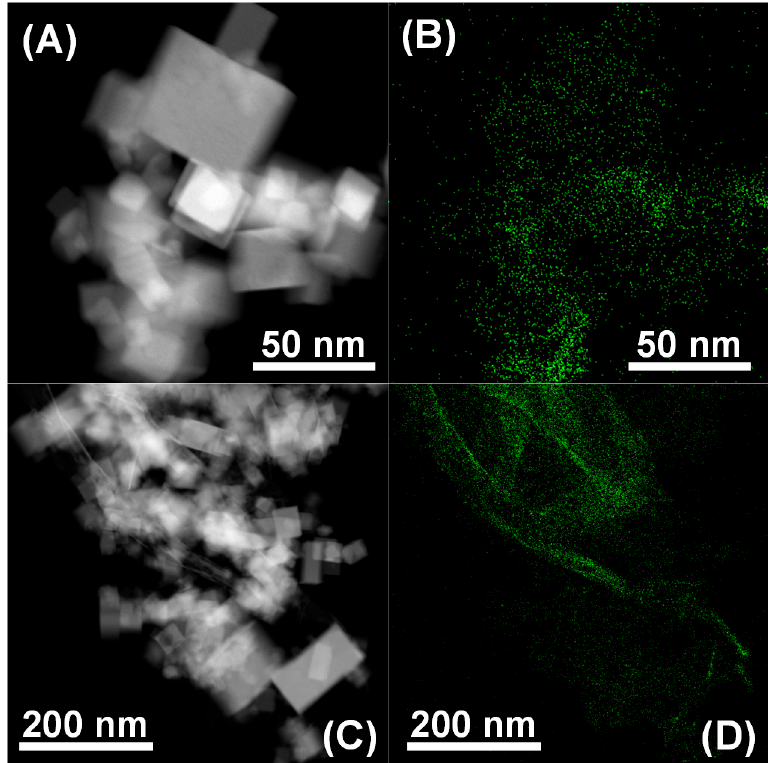
Figure 2. ( A ) and ( C ) Representative high-angle annular dark field-scanning transmission electron microscopy (HAADF-STEM) images for the freshly prepared 5Ni-CeO 2 NCs catalyst; ( B ) and ( D ) the corresponding energy-dispersive X-ray spectroscopy (X-EDS) maps for Ni